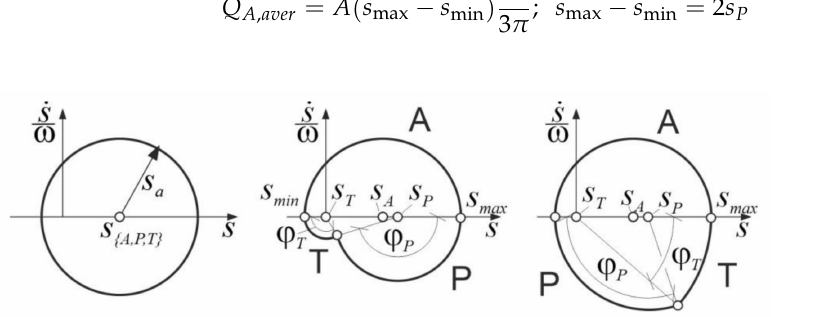
Figure 4. Phase space representation of ( a ): the general solutions of (2) for a specific phase; ( b ): for a switching sequence A-P-T (APTM); ( c ): for a switching sequence A-T-P